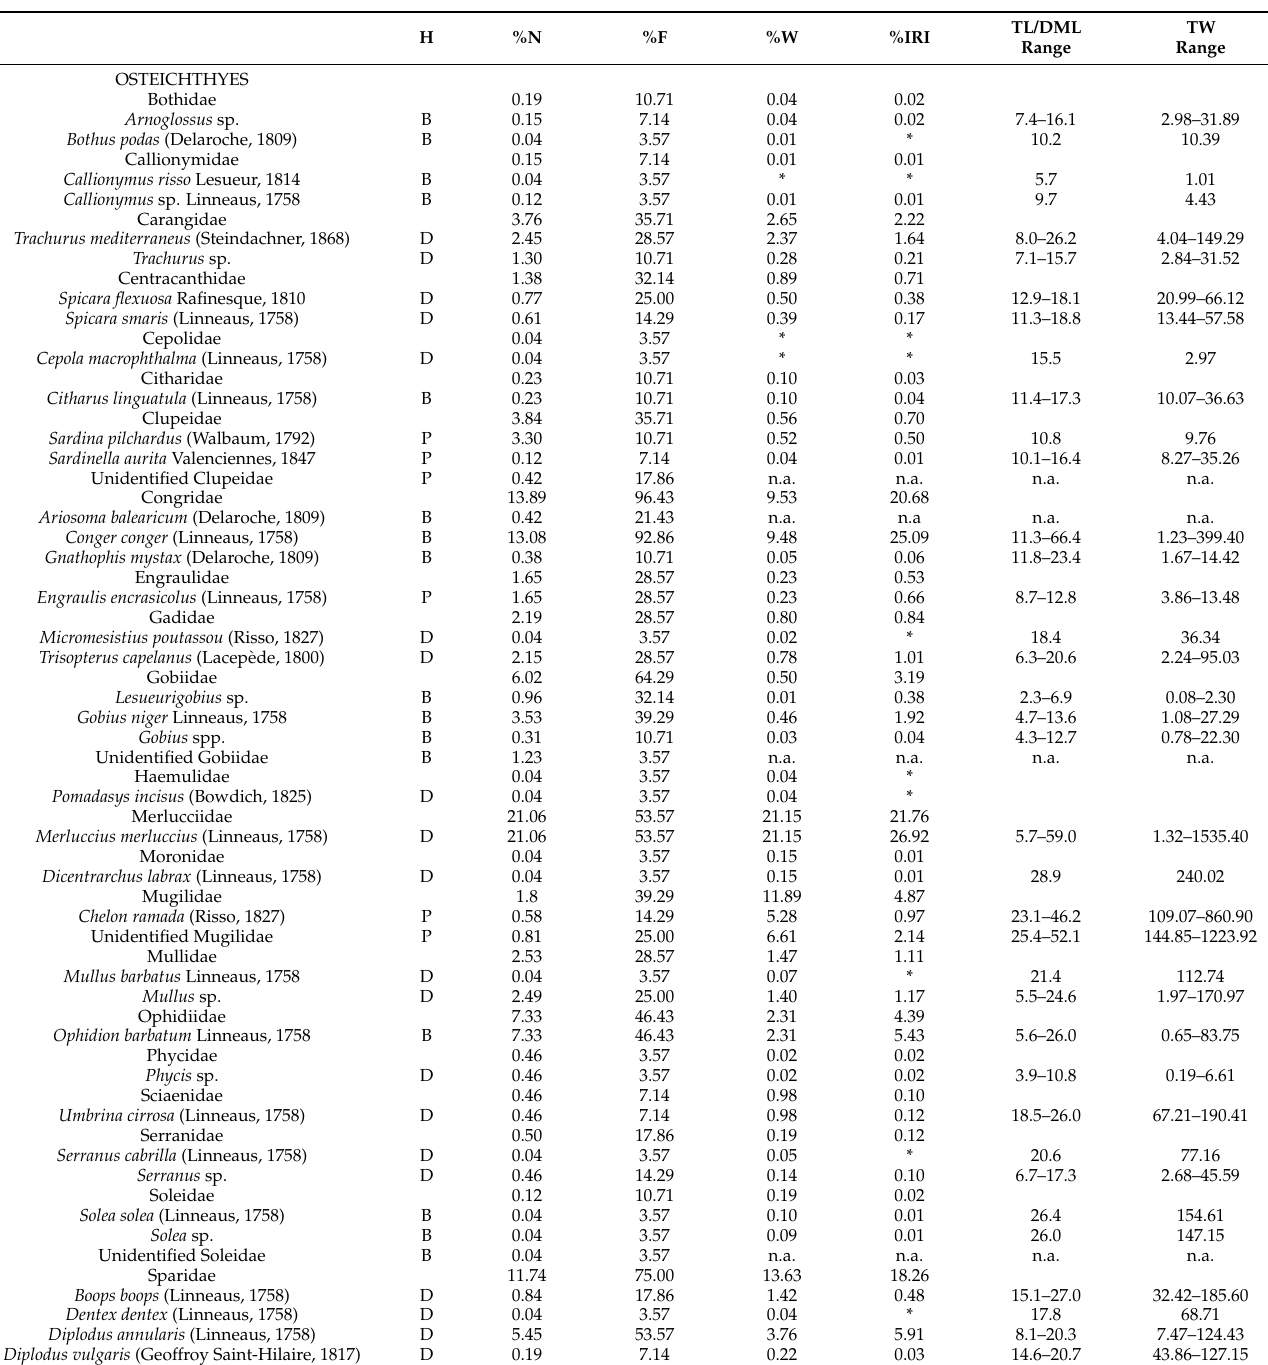
Table 2. Trophic spectrum of T. truncatus from the Tuscany area (northwestern Mediterranean Sea). For each prey item: %N, percentage in number; %F, percentage frequency of occurrence; %W, percentage in biomass; %IRI = percentage of the index of relative importance. TL: total length (cm); DML: dorsal mantle length (cm); TW: total weight (g); n.a.: not available; H: habit; B: benthic; D: demersal; P: pelagic. (* ≤